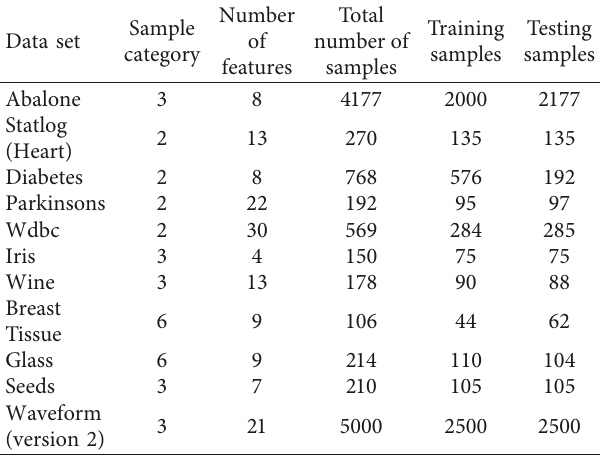
Table 3: Data set description of the selected UCI classification